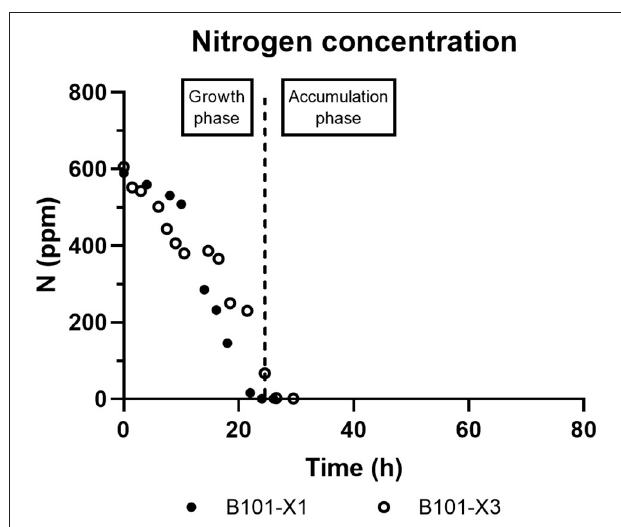
FIGURE 4 | B101-X1 and B101-X3 nitrogen concentration over time.